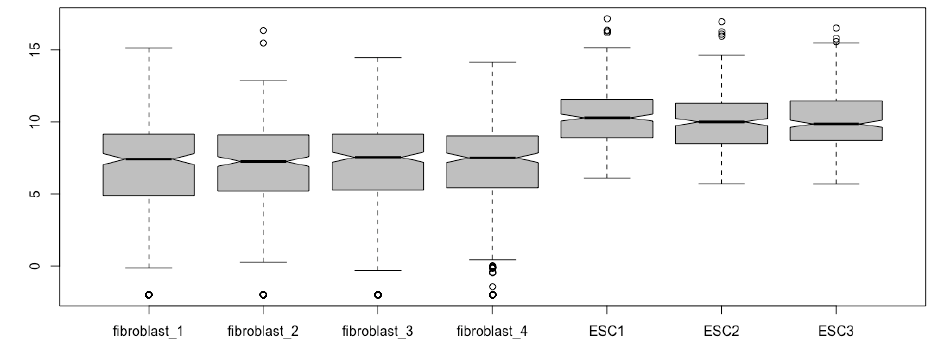
Figure 7. Fill the box bodies with a color using the argument col = “gray” .